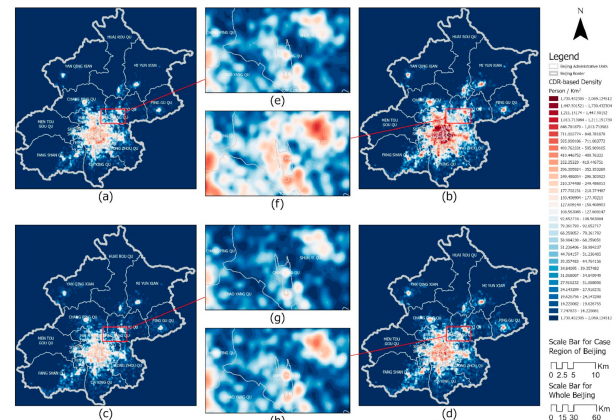
Figure A5. Four examples of the CDR-based people density distribution at different time points. ( a – d ) show the distributions in the whole of Beijing, while ( e – h ) illustrate an inner area of Beijing to show more details. ( a , e ) are at 6:00 a.m. 2 February 2015 while ( b , f ) are at 6:00 p.m. on the same day. ( c , g ) are at 6:00 a.m. 19 February 2015 (Spring Festival), while ( d , h ) are at 6:00 p.m. on the same